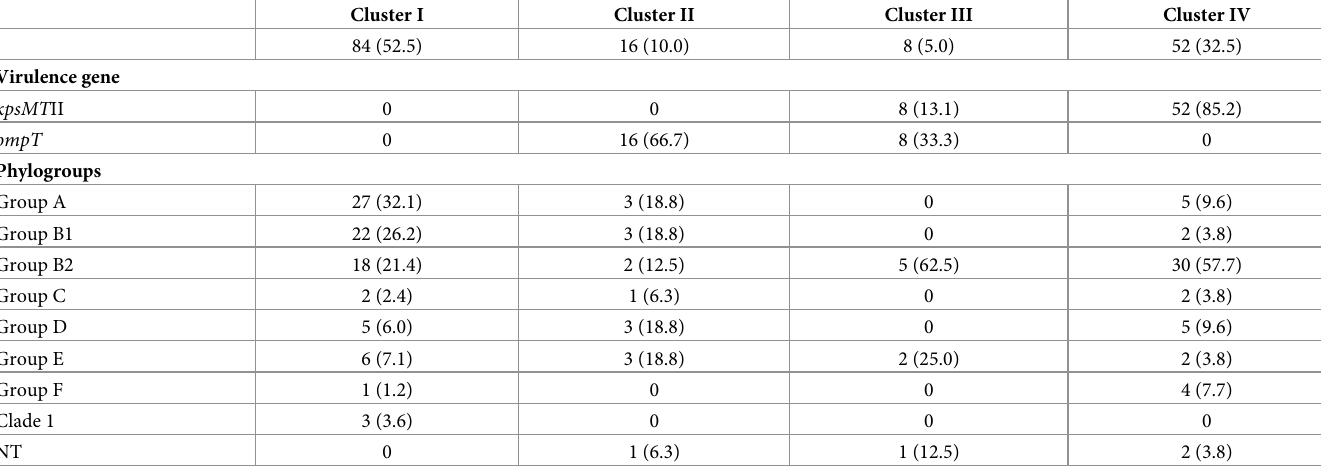
Table 11. Hierarchical clustering for distribution of capsule synthesis virulence genes among E . coli isolated from ASB cases, total